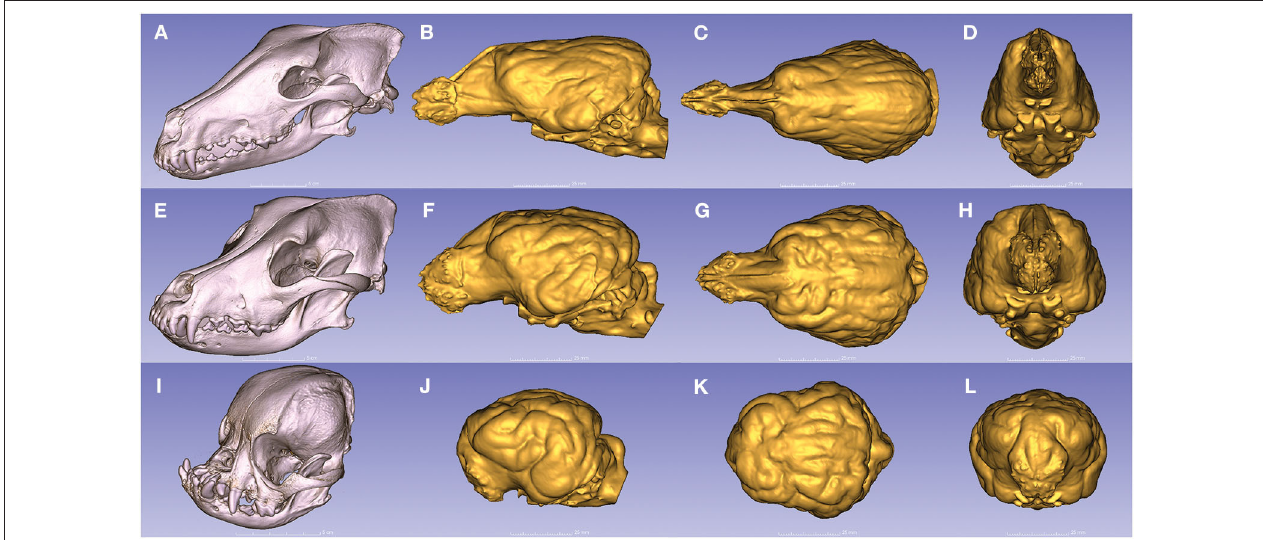
FIGURE 9 | Endocasts from dogs with the three main head types. (A) The dolichocephalic skull of a borzoi. (B–D) Endocast of a borzoi. (E) The mesocephalic skull of a Rhodesian ridgeback. (F–H) Endocast of a Rhodesian ridgeback. (I) The brachycephalic skull of a pug. (J–L) Endocast of a pug. (A,E,I) Left rostro-lateral view. (B,F,J) Left lateral view. (C,G,K) Dorsal view. (D,H,L) Rostral